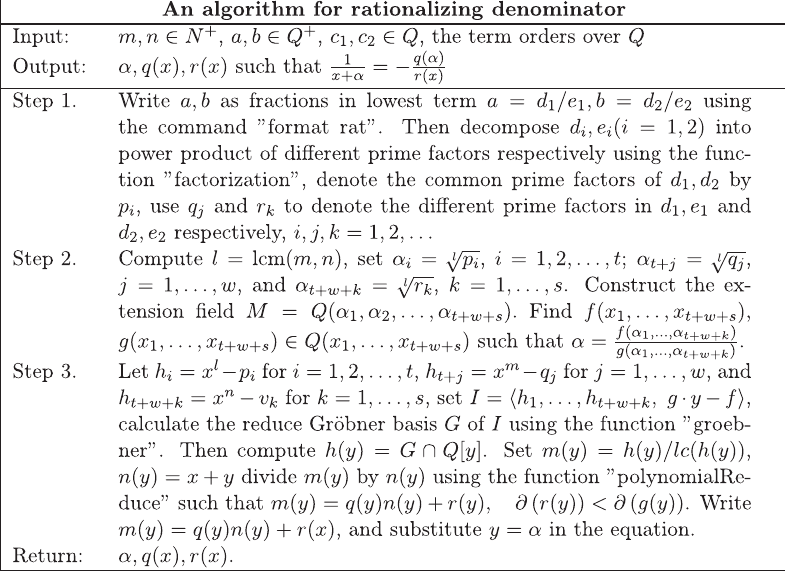
Figure 1: Denominator rationalized